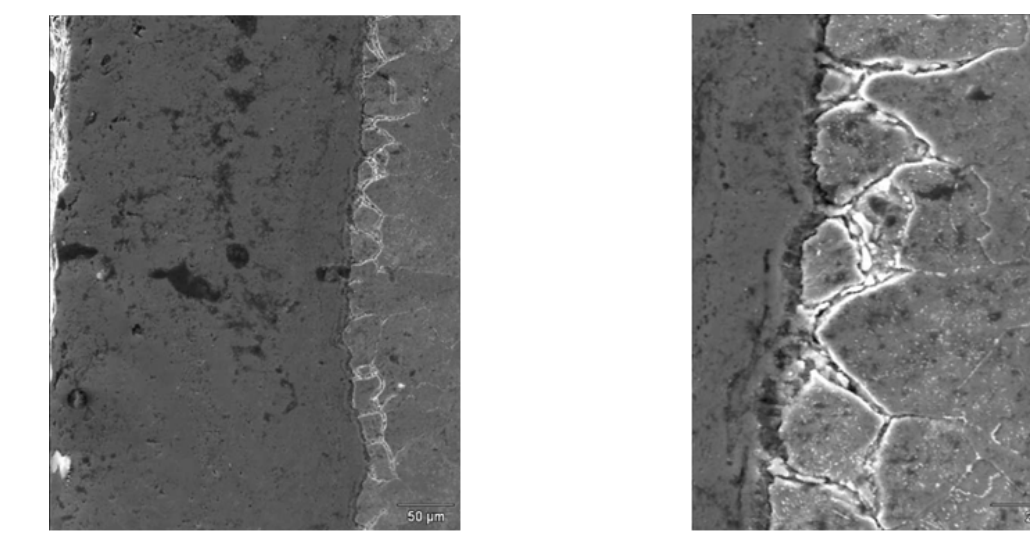
Figure 16: SEM analysis. External pipe section scale – 350 X. Figure 17: SEM analysis. Magnification of a detail from Fig. 16. – 1300 X.